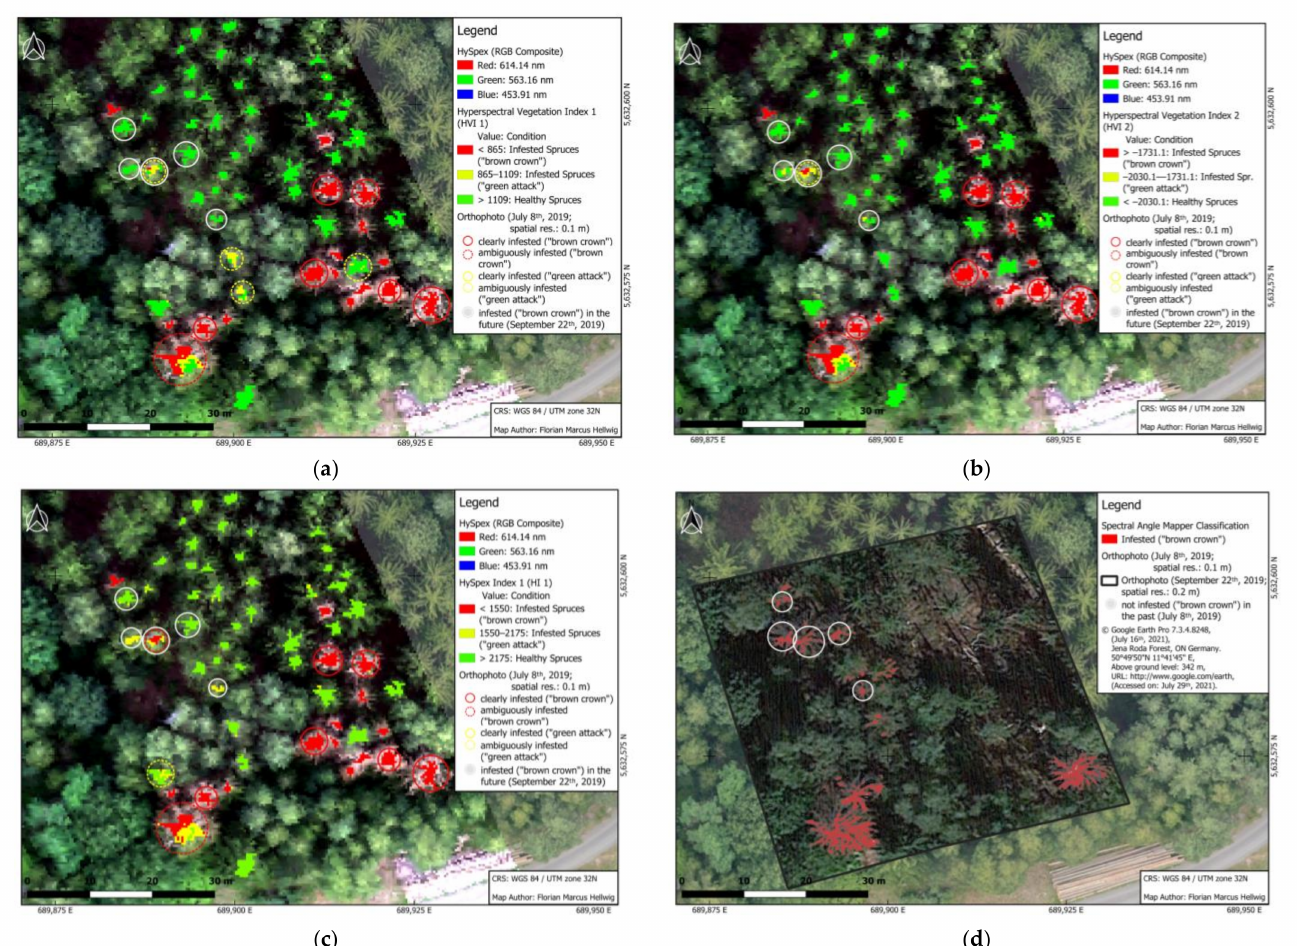
Figure 14. State of the spruces in the second study area using hyperspectral vegetation index 1 (HVI 1) ( a ), HVI 2 ( b ) and HI ( c ). Long-term validation of the spruces in the second study area. Comparison with a second orthophoto 76 days after the first infestation ( d ). Using the Spectral Angle Mapper (SAM) classification, five spruces (white circle) were clearly identified as infested (“brown crown”) in the second orthophoto (22 September 2019) that had no “brown crown” in the first orthophoto (10 July 2019) ( d ). A total of eleven spruces were found to be (ambiguously) infested with HVI 1. Of these, one out of five spruces was detected in an early stage of infestation (green attack) (white circle) ( a ). For HVI 2, there were eight spruces and one out of five spruces, with two others showing a tendency to infestation ( b ). For HI 1, there were nine spruces and definitely three out of five spruces ( c